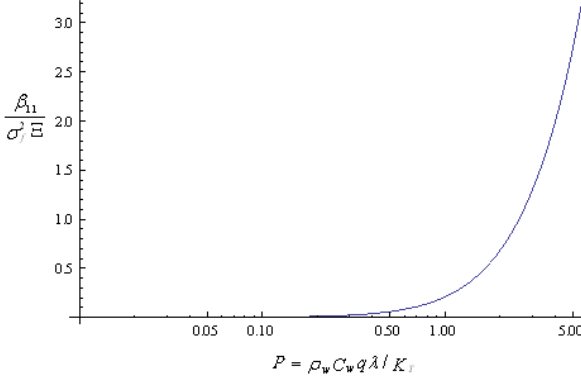
Fig. 2. Dimensionless longitudinal macroscopic dispersivity as a function of P where 4 = K T /( ρ w C w q) T